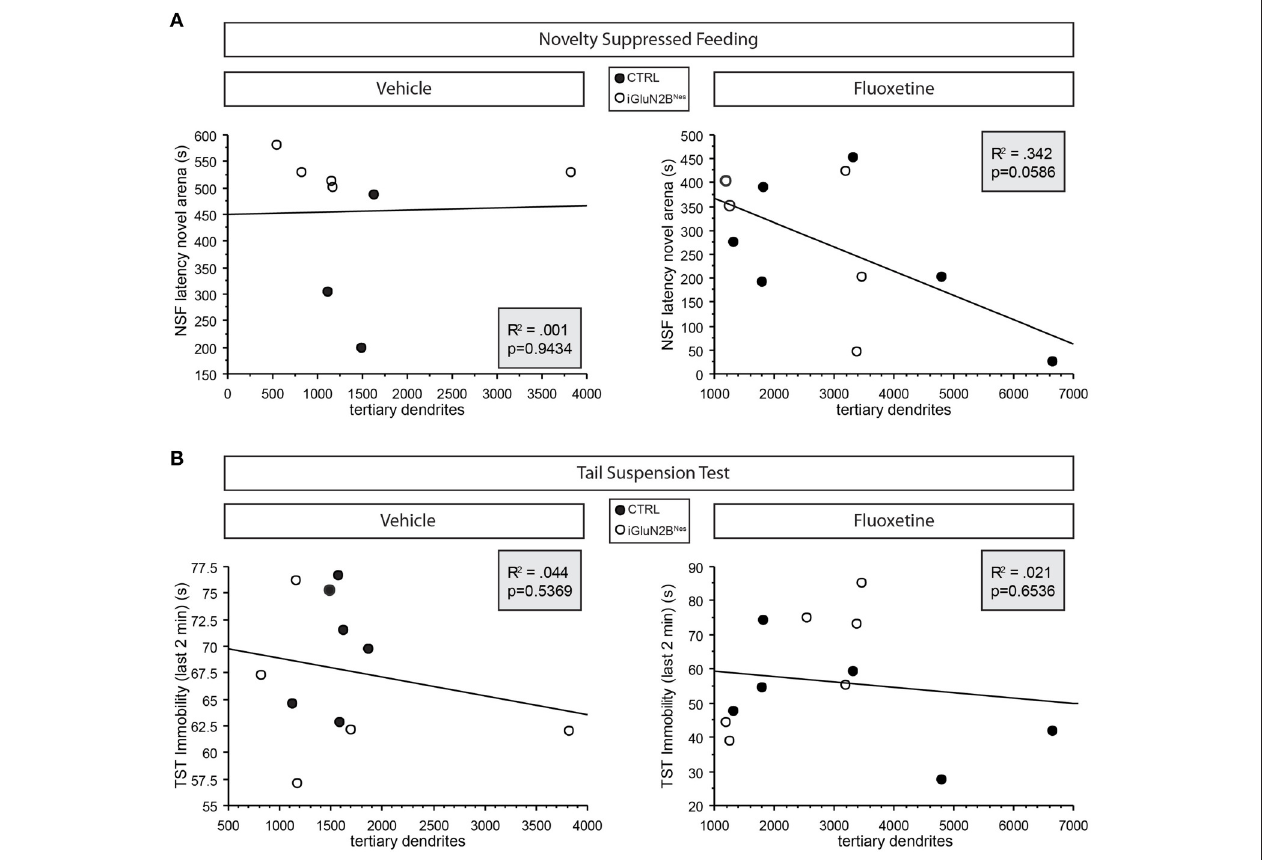
FIGURE 5 | Trend for dendritic complexity in FLX-treated mice to correlate with behavioral response in the neurogenesis-dependent NSF test. (A) Higher numbers of immature neurons with tertiary dendrites tended to correlate with a lower latency to feed in NSF in FLX-treated mice (right) but not those mice that received VEH (left) . (B) Similar correlations were not evident in the neurogenesis-independent TST. Tertiary dendrite counts were obtained for 6 mice/group (see Table 2 ). For the NSF correlations, any mouse that had been censored was excluded from the correlations. For the TST correlations, 1 VEH-treated iGluN2B Nes mouse was not included because he had to be removed from the TST for hanging onto his